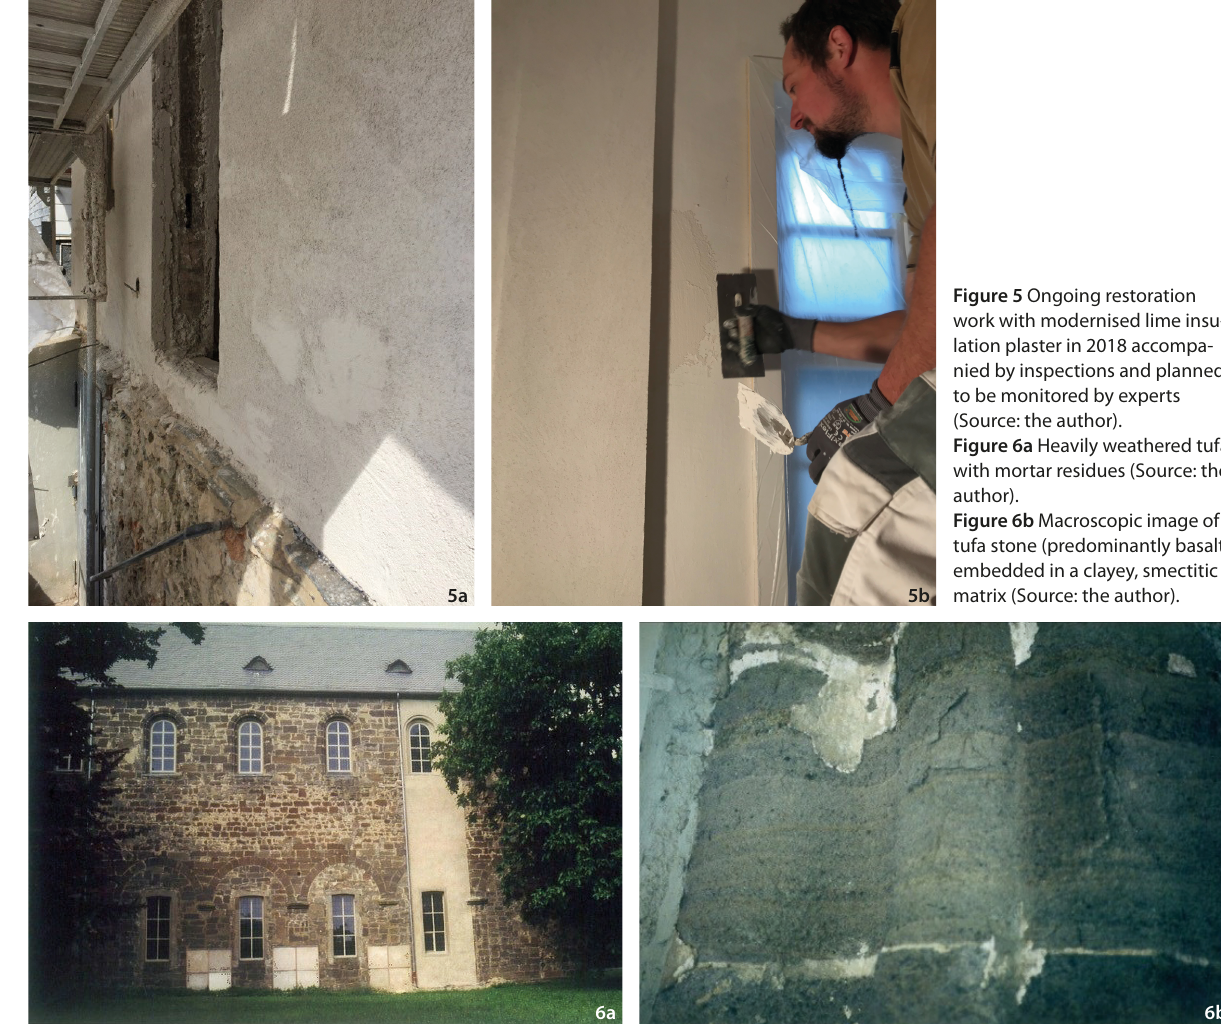
Figure 5 Ongoing restoration work with modernised lime